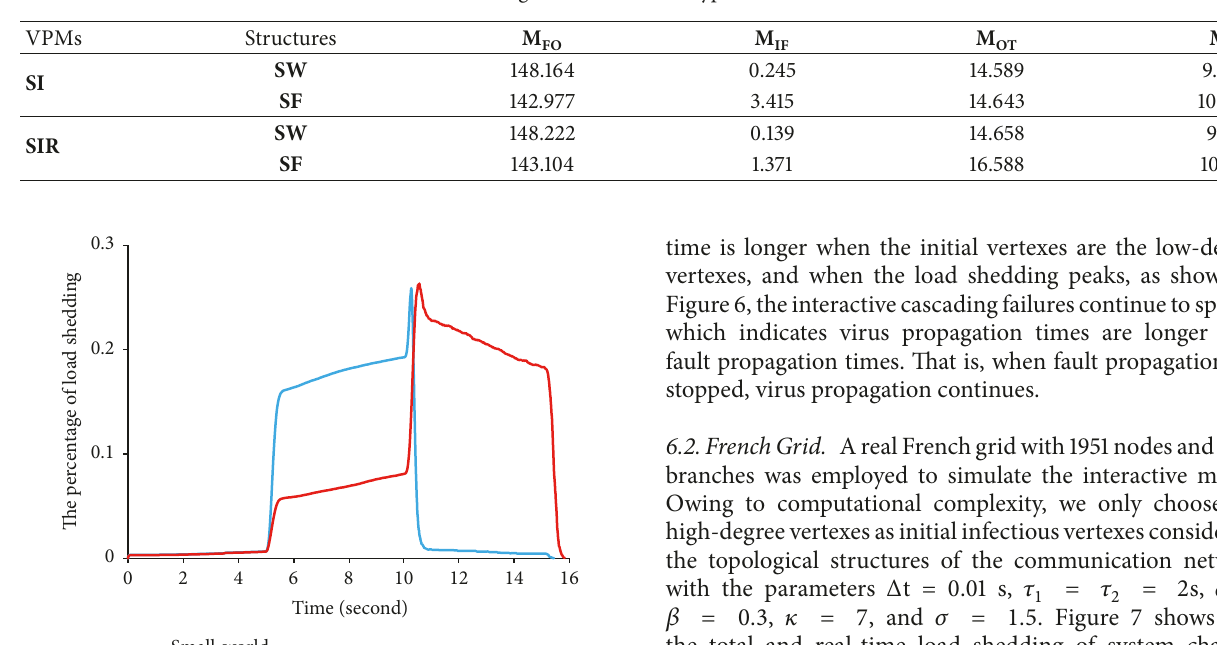
Table 1: Average numbers of four types of fault branches.